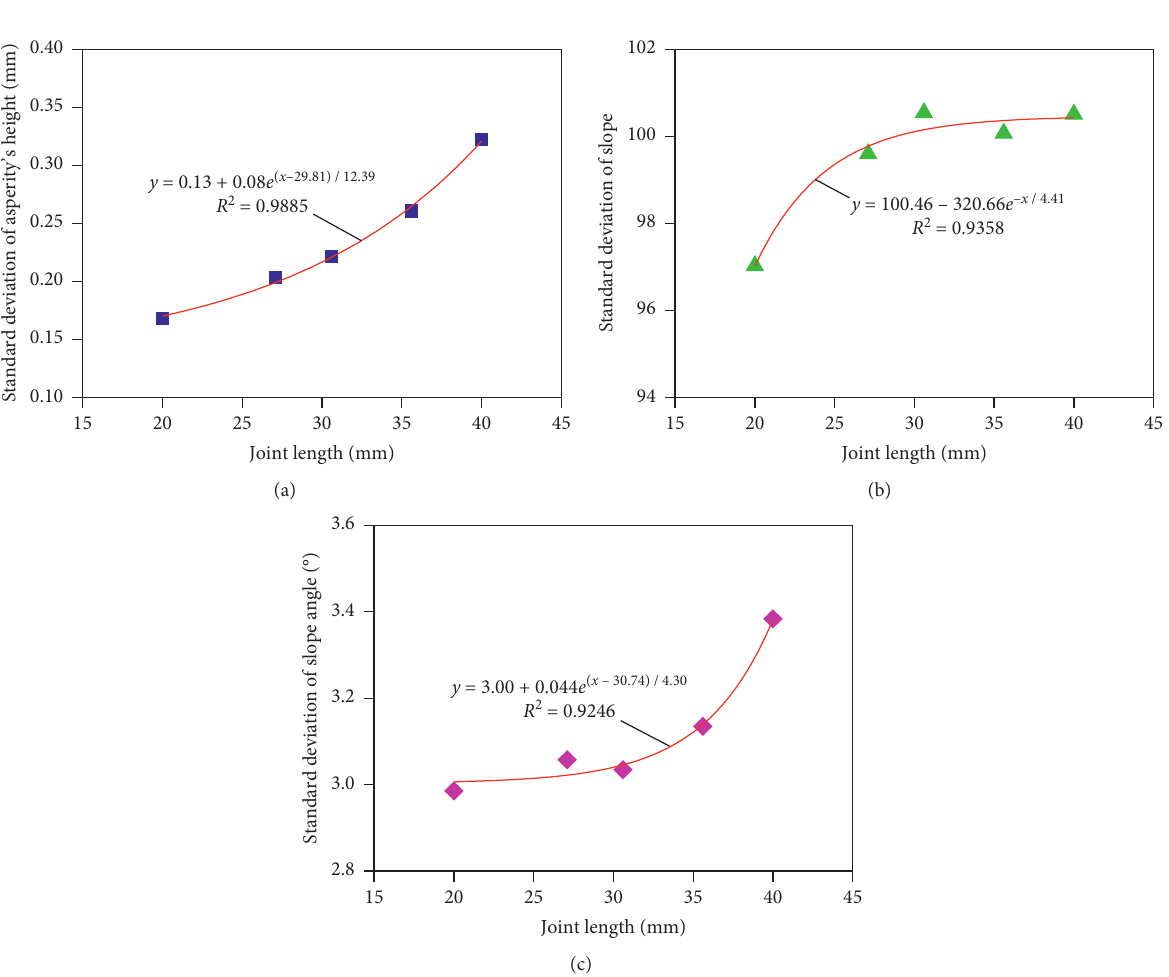
Figure 9: Relations between joint length and standard deviations of (a) asperity’s height, (b) slope, and (c) aspect,